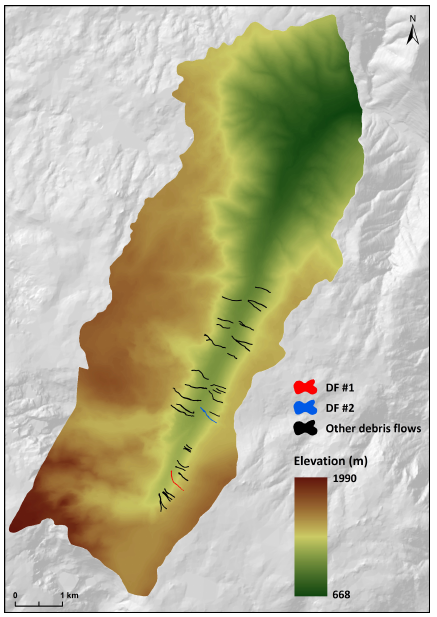
Figure 4. Digital elevation model (DEM) of the study area and de- bris flows that occurred in